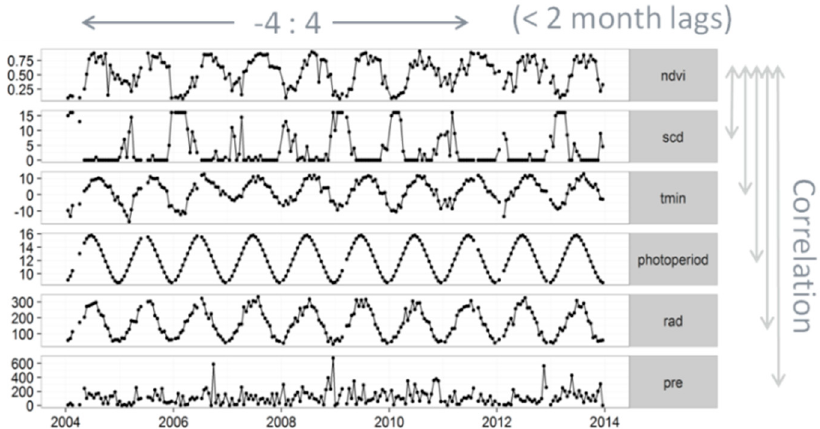
Figure 4. Schematic representation of the different single parameter cross-correlations. Abbreviations: NDVI, (normalized difference vegetation index), pre (precipitation), rad (radiation), SCD (snow cover duration), and tmean (mean temperature).